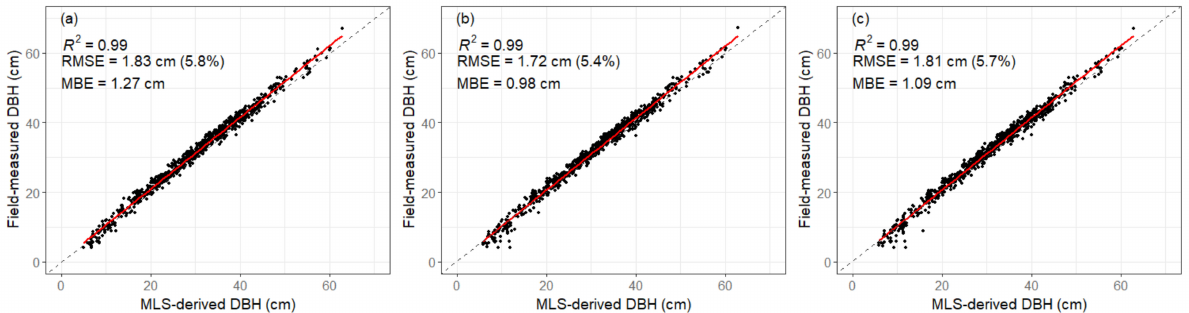
Figure 10. Correlation between field-measured and MLS-derived DBH. ( a ) The best MLS-derived DBH result from the VBH method, ( b ) the best result from the MLS measurements taken at field height and ( c ) the best result from the MLS measurements taken at a fixed height above the DTM. The dashed lines represent a 1:1 line and the red lines represent a fitted linear model with linear equation and R 2